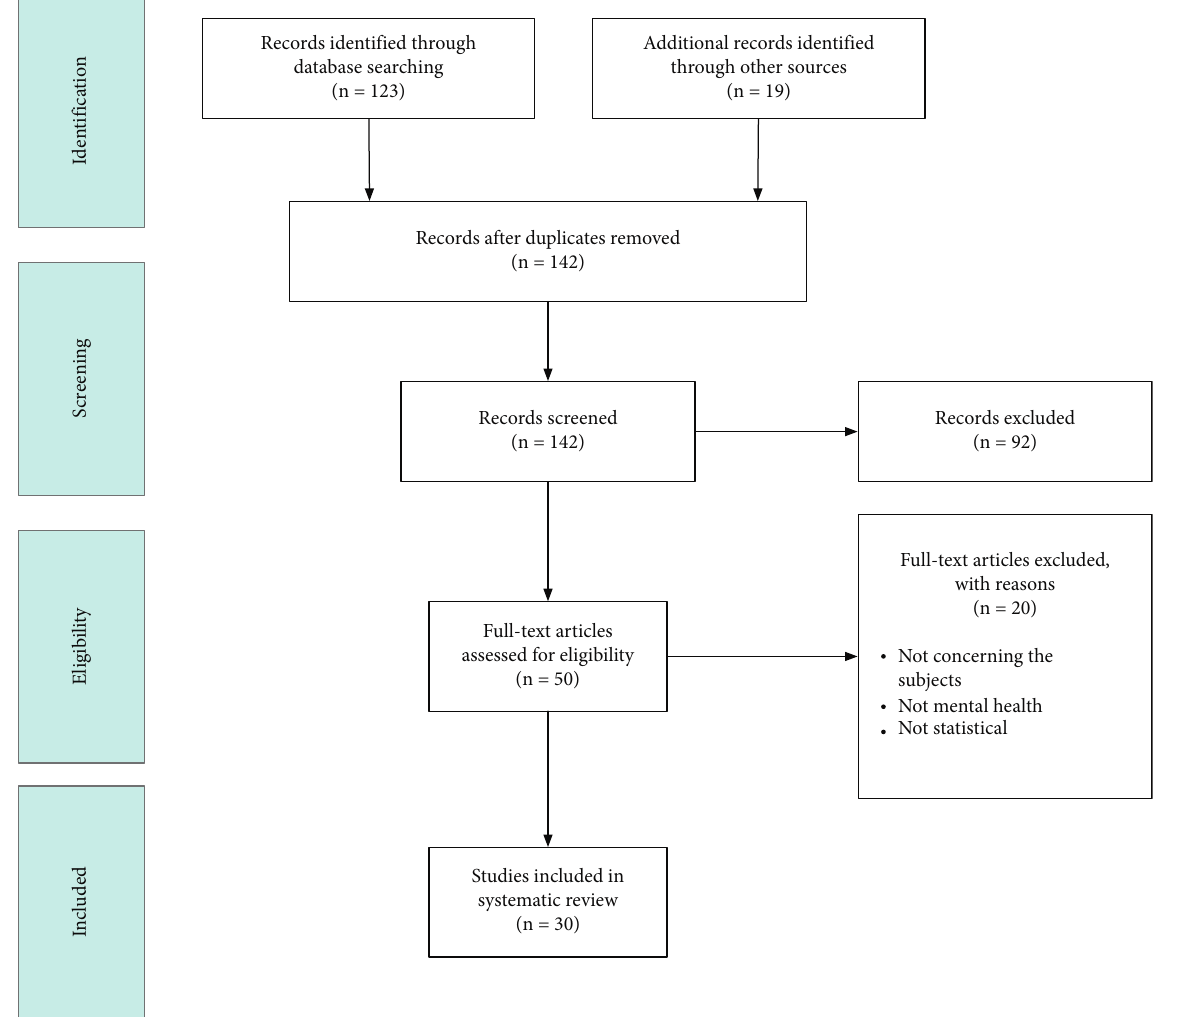
Figure 3: PRISMA flow chart of the study selection process.